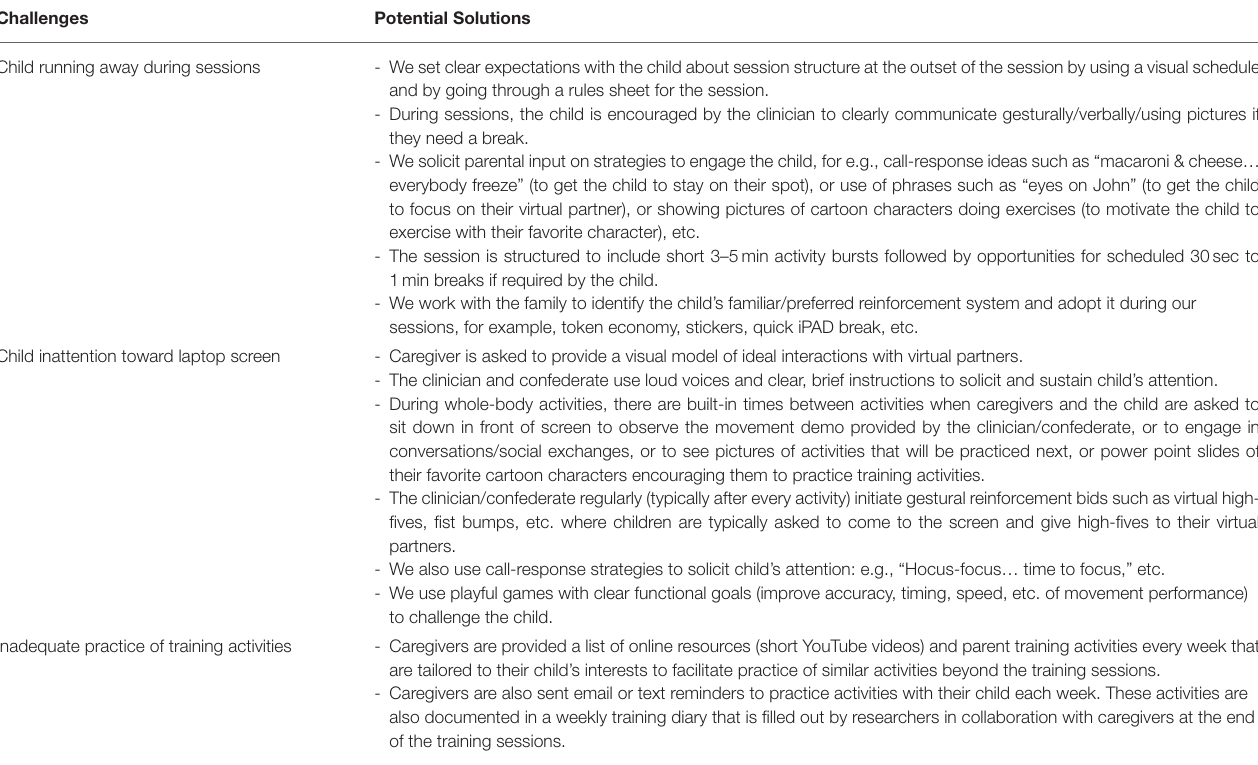
Challenges Potential